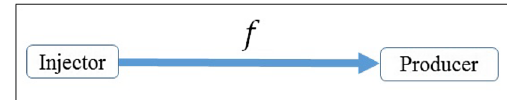
Table 1 Optimized parameters used for the simulation of the Moghadasi et al. (2004) experiments